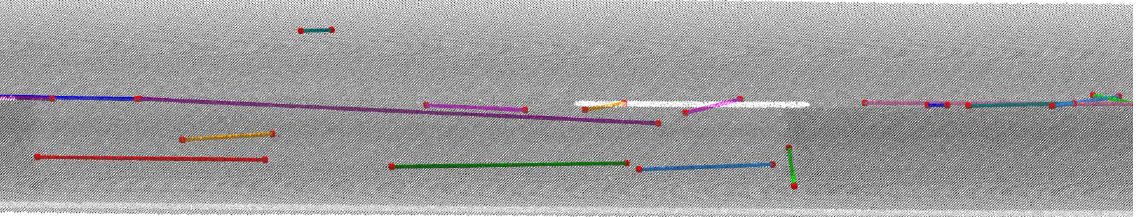
Figure 7. Distance between clusters, defined as the shorter edge connecting their end points (cir- cled in orange). The orientation of the edge is calculated. Figure 8. Connected clusters. 2.3. Crack Parametrization